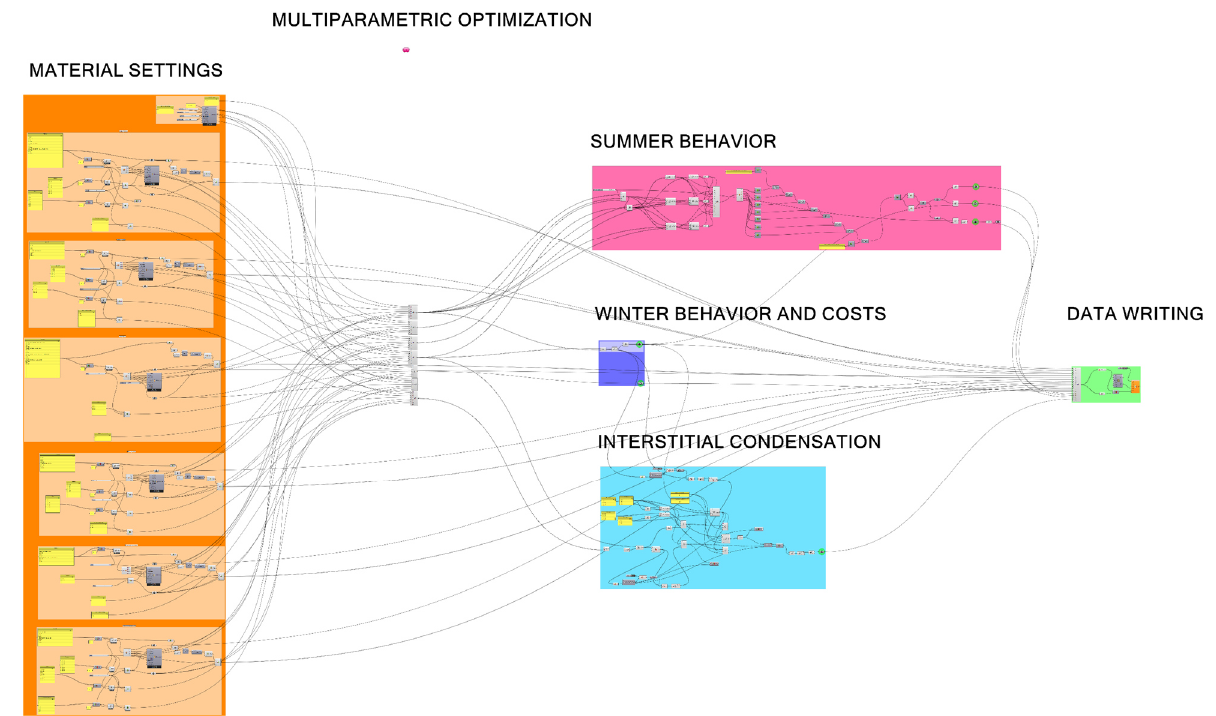
Figure 1. The algorithm combines different materials and thicknesses and evaluates the energy performance of the